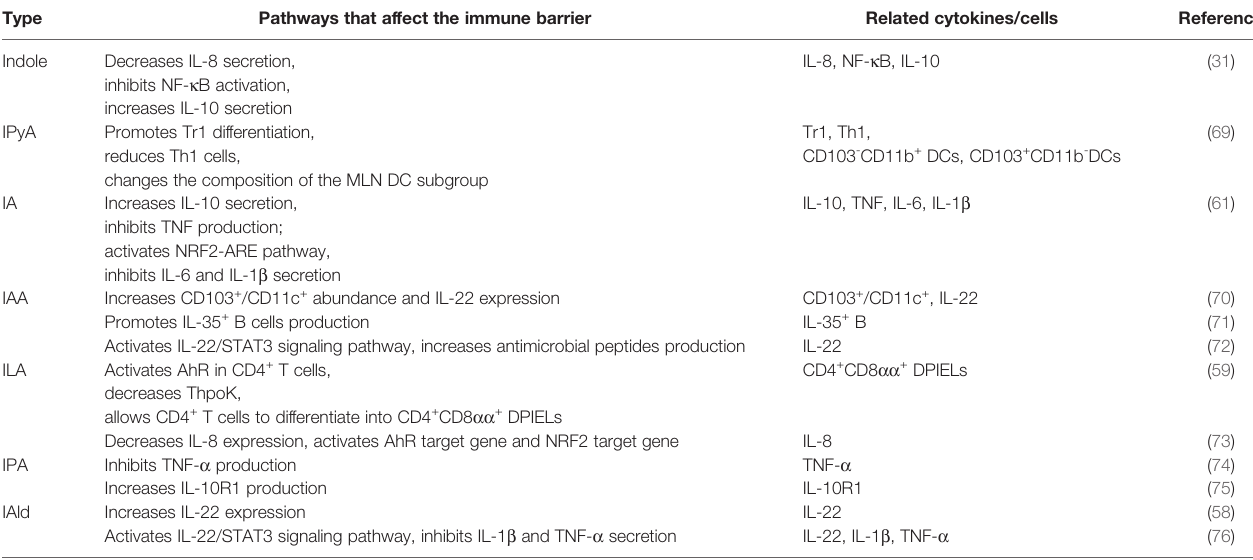
TABLE 1 | Effects of indoles on intestinal immune barrier.